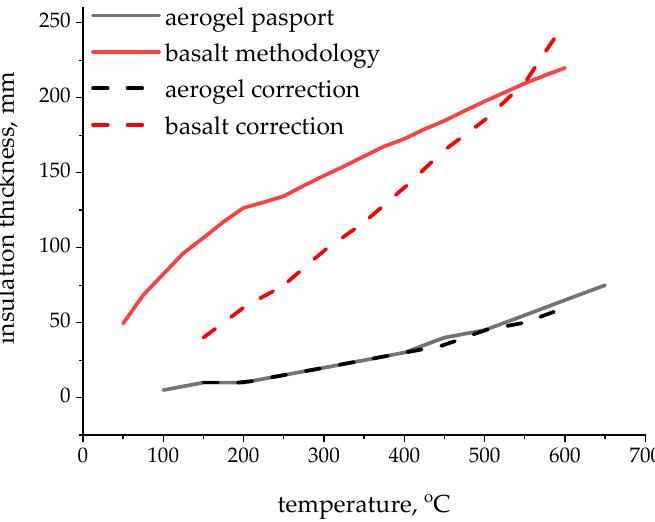
Figure 11. The minimum thickness of the studied insulating materials, taking into account the adjustment from numerical